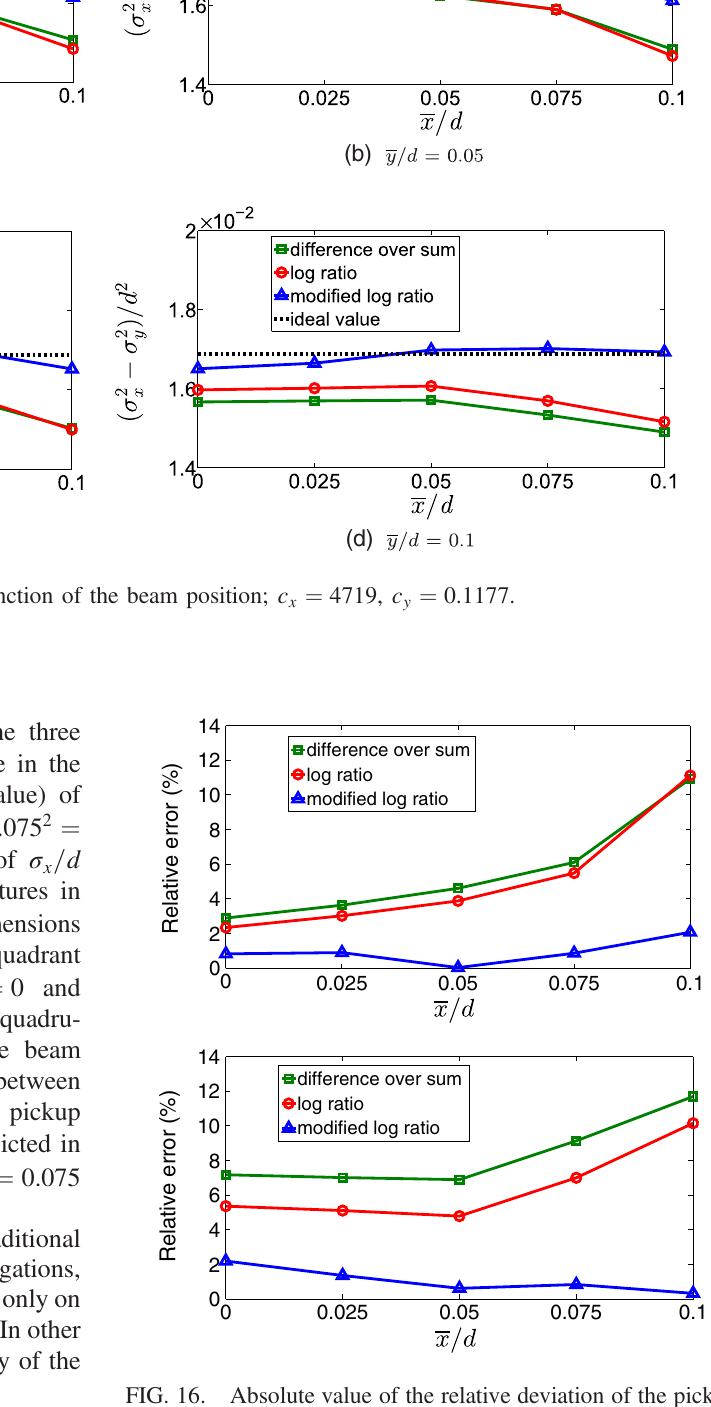
FIG. 16. Absolute value of the relative deviation of the pickup values of ð σ 2 x − σ 2 y Þ =d 2 from its ideal value as a function of the beam position; setting beam size: σ x ¼ 15 mm, σ y ¼ 7 . 5 mm; (above) ¯ y=d ¼ 0 . 075 , (below) ¯ y=d ¼ 0 . 1